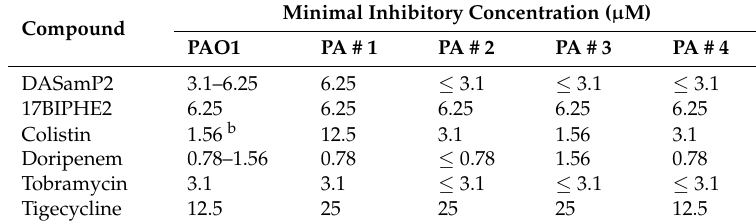
Table 2. Antimicrobial activity of the selected peptides a and antibiotics against laboratory and clinical isolates of P.